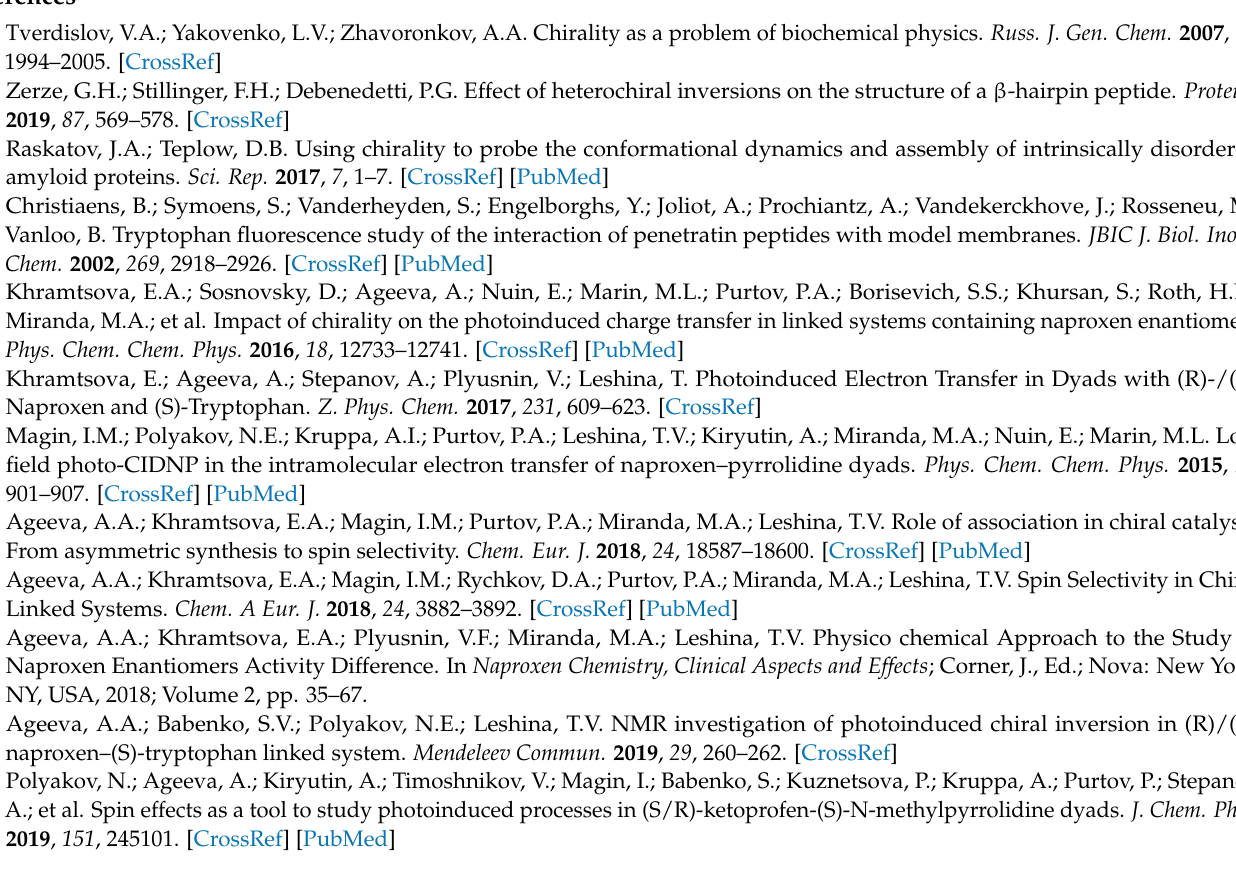
Table S1: CIDNP coefficients (K = I pol /I eq ) of ( R,S )- and ( S,S )-diastereomers of NPX-Trp dyad in acetonitrile/benzene mixture ( ε = 14.5), Figure S7: Structure of KP-Trp dyad with marked up